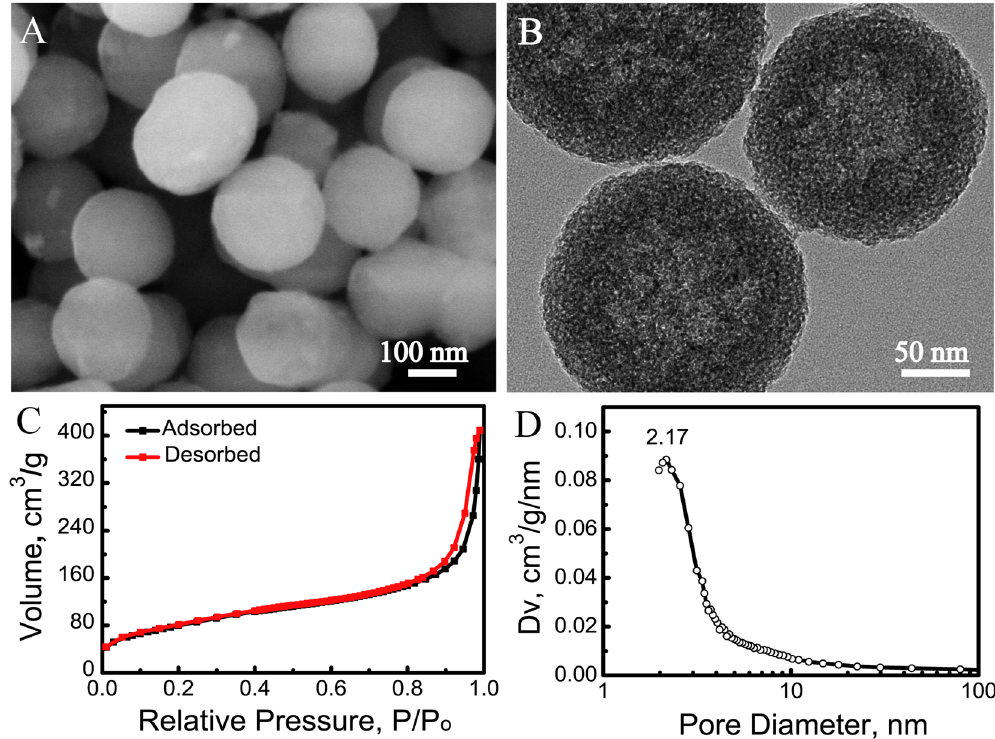
Figure 2. Characterization of scaffolds. ( A ) SEM image, ( B ) TEM image, ( C ) Nitrogen adsorption-desorption isotherm and ( D ) Pore size distribution curve of mesoporous CaSiO 3 microspheres. SEM, emission scanning electron microscopy; TEM, transmission electron